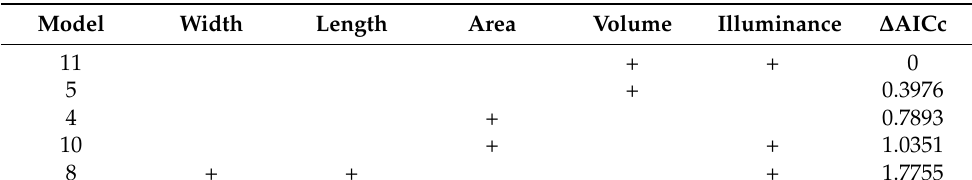
Table 3. Linear regression models with empirical support (i.e., ∆ AICc ≤ 2) that were used to predict differences in greenery for interior spaces estimated using manual and automated methods. A “+” symbol indicates the variable was included in the model.